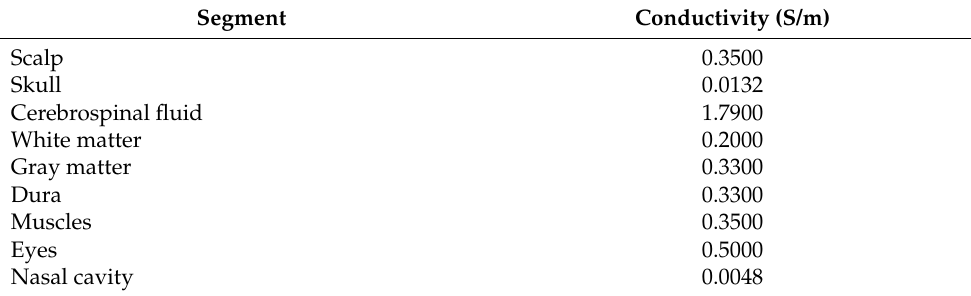
Table 1. Conductivity values of head model